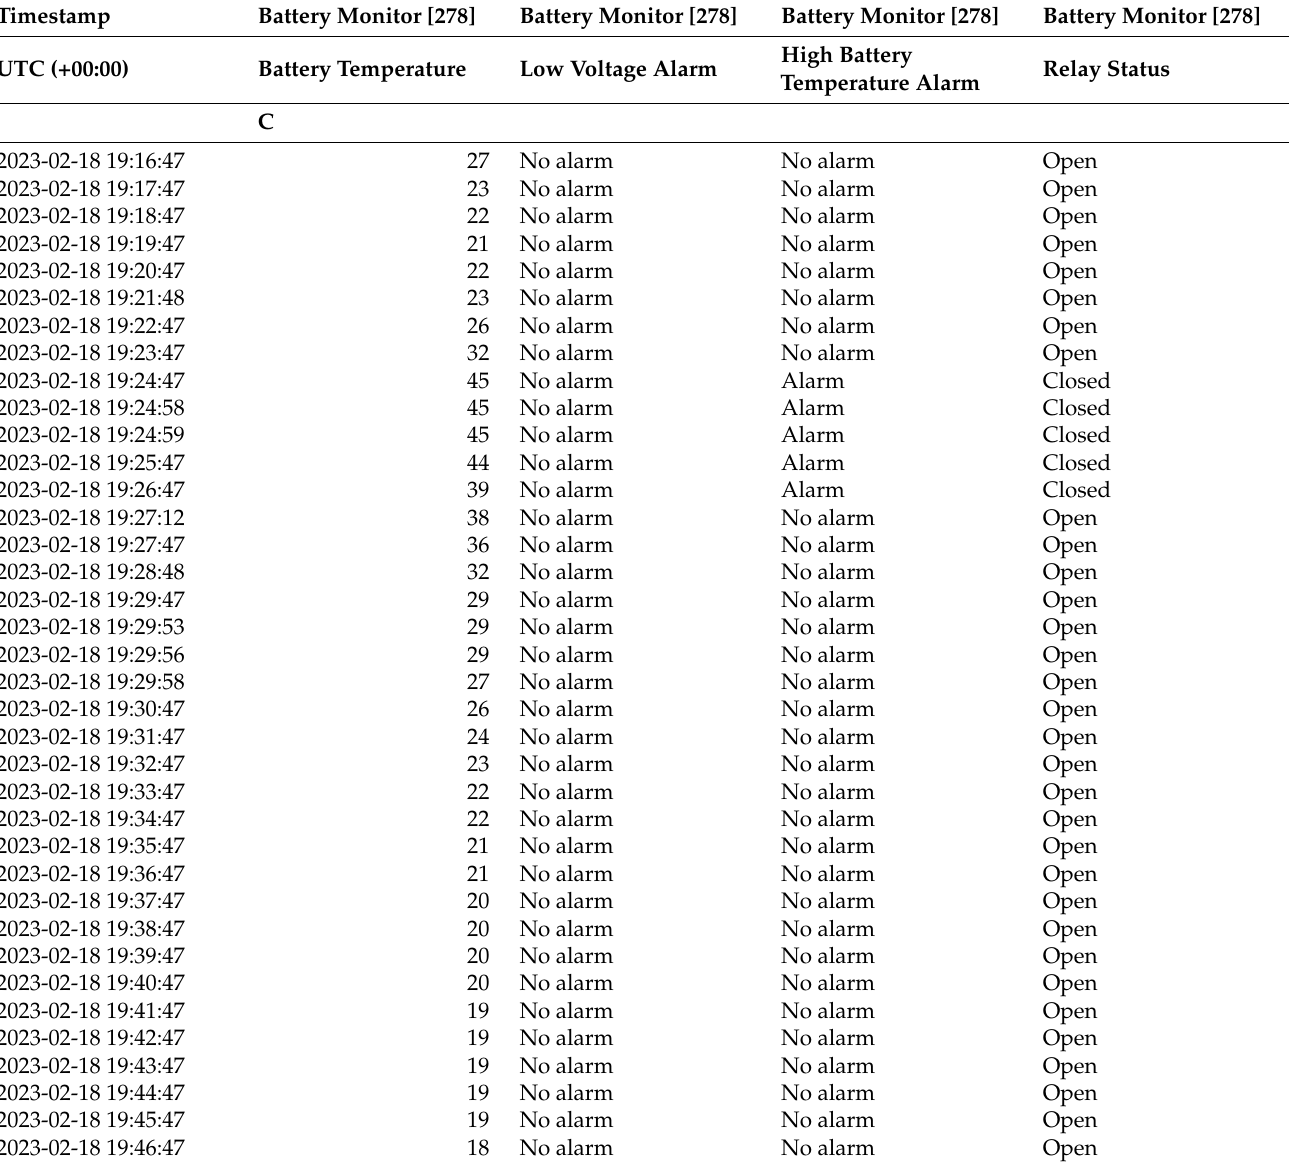
Table 4. Capture in test based on high-temperature alarms using the temperature sensor ASS000100000 and relay integrated into the BMV-712